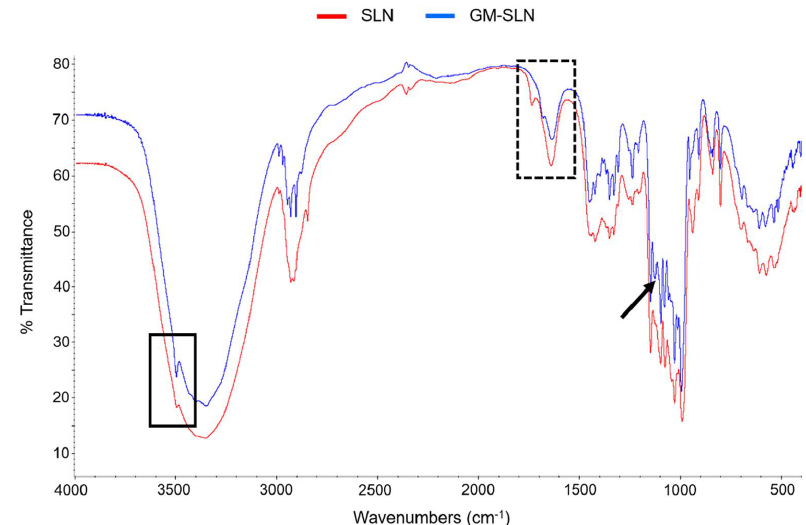
Figure 3. Fourier Transform Infrared Spectroscopy (FT-IR) spectra of SLNs and the GM-SLN vector. Black arrow points to the peak at around 1150 cm −1 present in the GM-SLN spectrum. Black square indicates the difference in the intensity of peak at 3500 cm −1 between the two spectra. Dashed square shows the displacement of bands at around 1700–1800 cm −1 , probably indicating formation of hydrogen bonds. GM-SLN: galactomannan SLN-based vector. SLN: solid lipid nanoparticle.